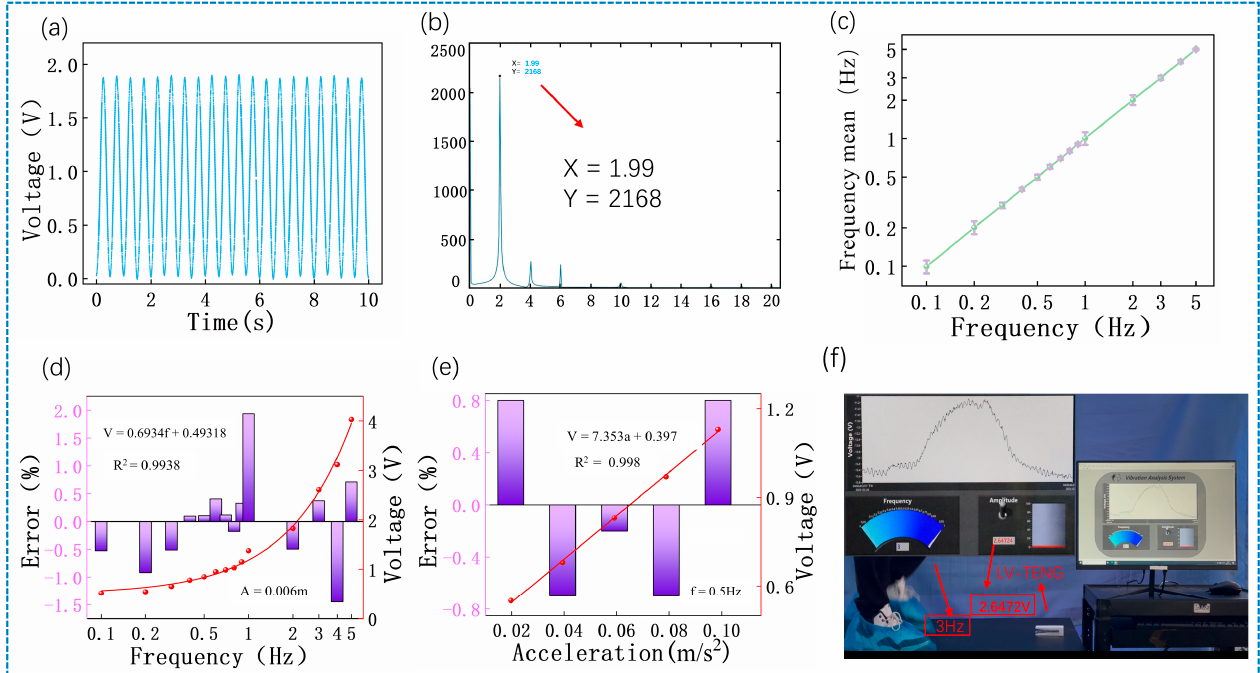
Figure 4 . Performance of the LV-TENG as a low frequency vibration sensor. ( a ) Output voltage of the LV-TENG at f = 2.0 Hz and A=6.0 mm; ( b ) FFT analysis on output signal at f = 2.0 Hz and A = 6.0 mm; ( c ) FFT analysis for frequency detection; ( d ) Linear fitting between vibration frequency and peak output voltage; ( e ) Linear fitting between vibration acceleration and peak output voltage; ( f ) Demonstration of the LV-TENG for low-frequency vibration monitoring.